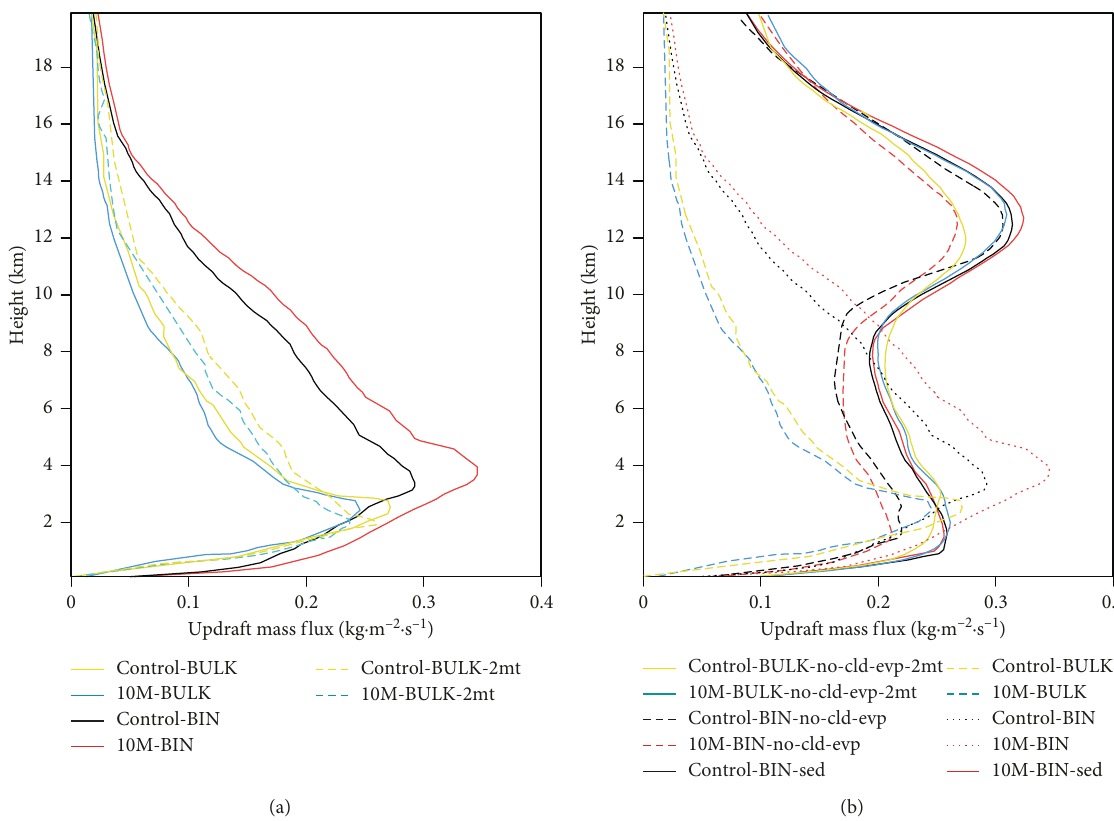
Figure 12: (a) Vertical distributions of the time- and domain-averaged updraft mass fluxes for the standard runs, the control-BULK-2 mt run, and the 10M-BULK-2 mt run. (b) Vertical distributions of the time- and domain-averaged updraft mass fluxes for the simulations in Figure 10 except for the fact that the control-BULK-no-cld-evp run and the 10M-BULK-no-cld-evp run are replaced with the control- BULK-no-cld-evp-2mt run and the 10M-BULK-no-cld-evp-2 mt